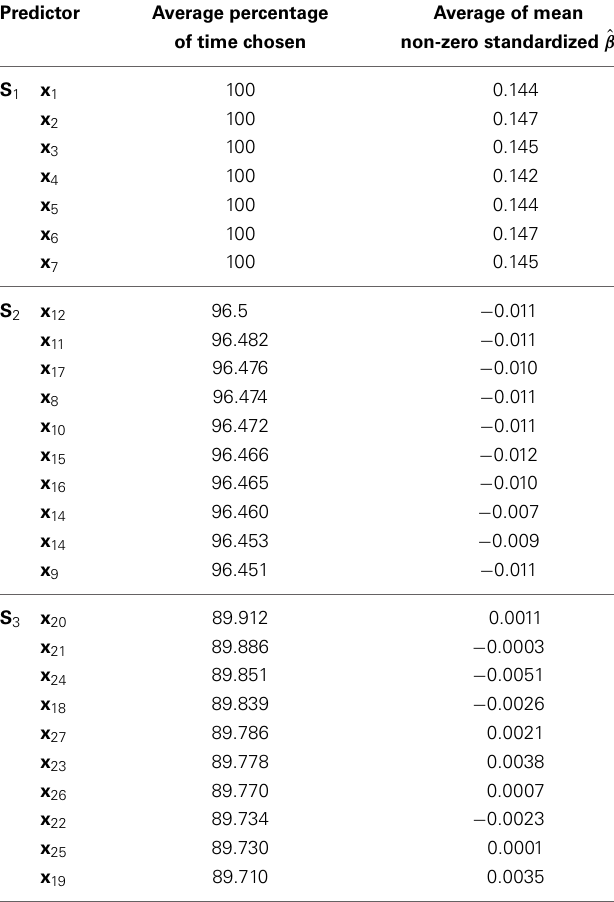
Table 1 | From all-possible SPLS conducted on D = 1000 samples from the same